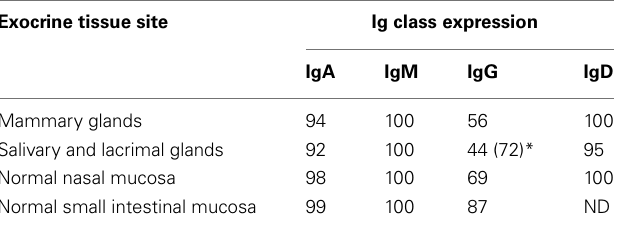
Table 1 | J-chain positivity (%) of mucosal plasmablasts and plasma cells.